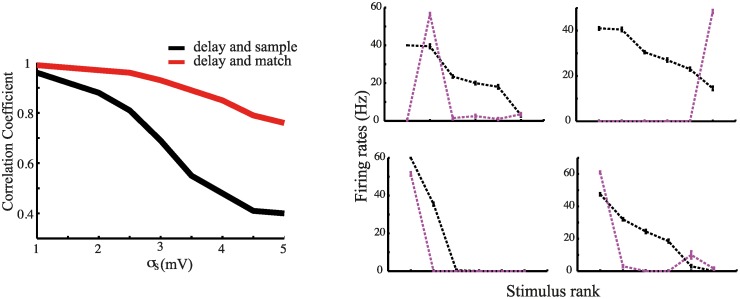
Response heterogeneity.Left panel: Correlation coefficient between the activity averaged across all memory representations during sample and delay (black curve) and during match and delay (red curve) as a function of the variance of the input currents. Right panel: examples of four cells tuning curves at sample -in black- and delay -in magenta- for σ
s = 4 mV. Stimuli are ranked from best to worst according to the responses to the sample.